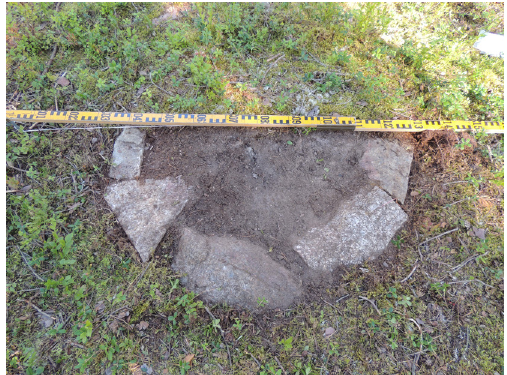
Figure 8. Rounded hearth without stone packing from area 1, NHB 166:10. Bones in the hearth are dated to the period AD 1660-1950. Artifacts found on the site suggest the 19 th